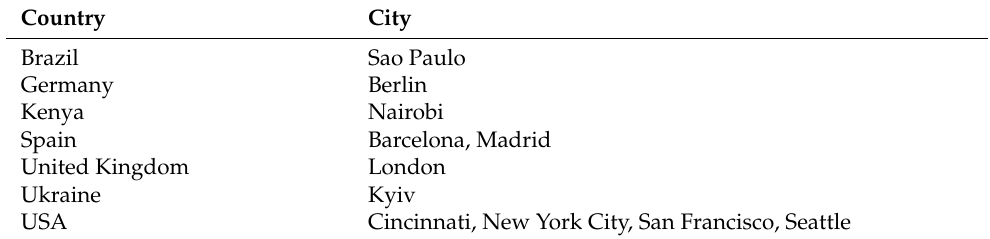
Table 2. Cities used for the case